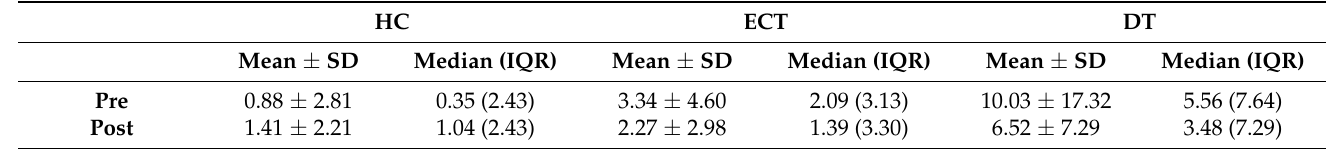
Table 5. Descriptive statistics corresponding to the Group by Session ANOVA conducted on the conflict effect estimated on error rate